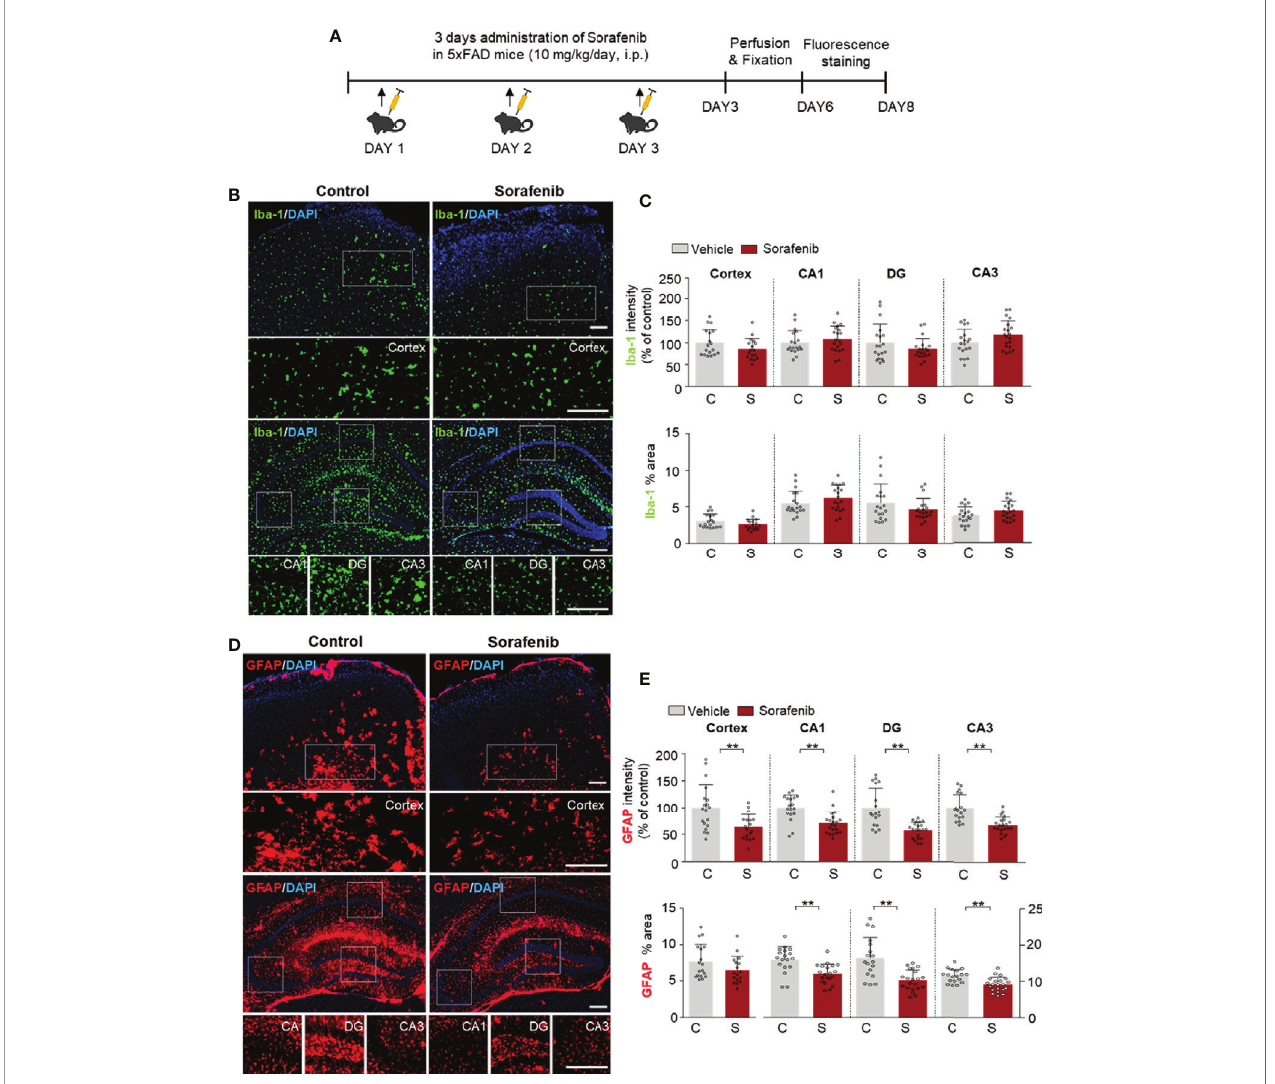
FIGURE 8 | Sorafenib suppresses A b -mediated astrogliosis in 5xFAD mice. (A) Scheme for the treatment of 5xFAD mice with sorafenib. (B, D) Immuno fl uorescence staining with anti-Iba-1 and anti-GFAP antibodies of brain slices from 5xFAD mice treated as described in (A) . (C, E) Quanti fi cation of the data in (B, D) (analyzed number of brain slices/images (n); Vehicle: =21, Sorafenib: n= 18). **p < 0.01. Scale bar = 200 m